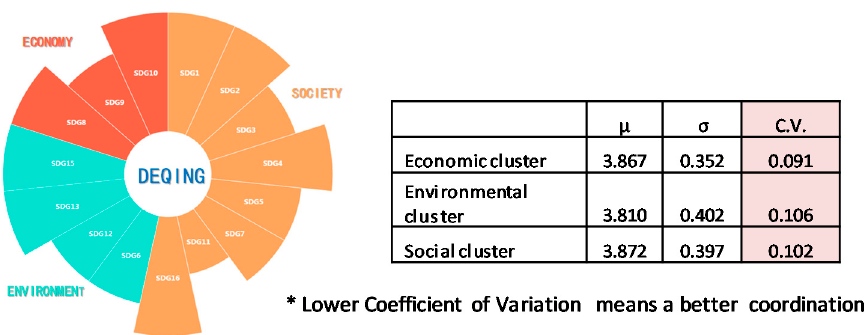
Figure 10. Assessment result of three SDG clusters in Deqing.